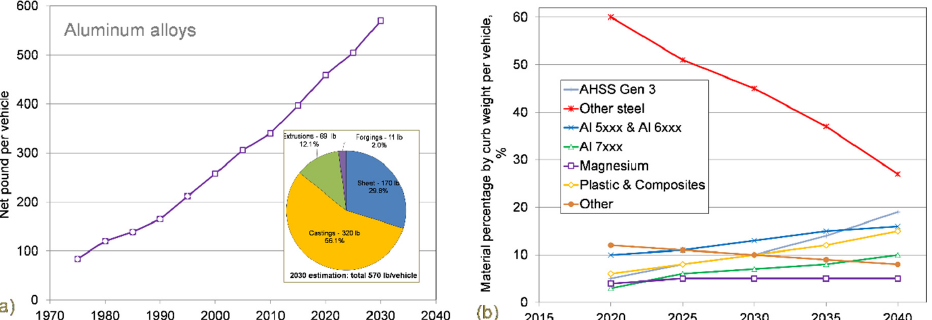
Figure 11. Current and predicted contribution of major automotive materials: ( a ) aluminum content growth in North American vehicles based on data from [47] and ( b ) average vehicle structure (body ‐ in ‐ white and closures) material percentage by curb weight per vehicle based on data from [49].